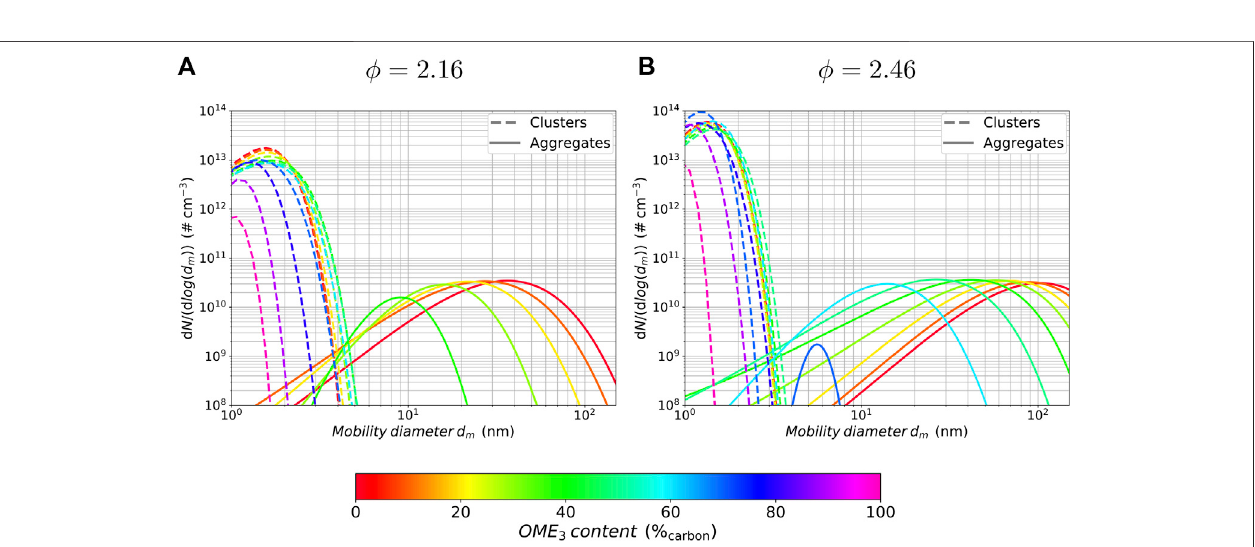
Frontiers in Mechanical Engineering |